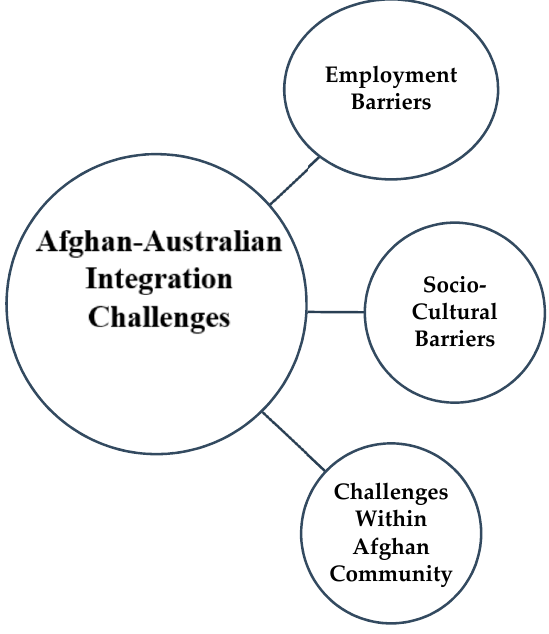
Figure 2. Main themes that emerged from qualitative data.